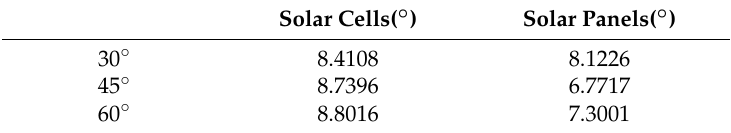
Figure 12. Comparison of BRDF measurement results between solar cells and solar panels. ( a ) θ i = 30 ◦ ; ( b ) θ i = 45 ◦ ; ( c ) θ i = 60 ◦ . The distance between the two points corresponding to 1/2 of the peak of the BRDF curve was defined as the half width of the BRDF, denoted as ∆ θ . The half-width of the solar cells and solar panels is shown in Table 4. Table 4. Comparison of Half Width of BRDF curve between solar cells and solar panels.